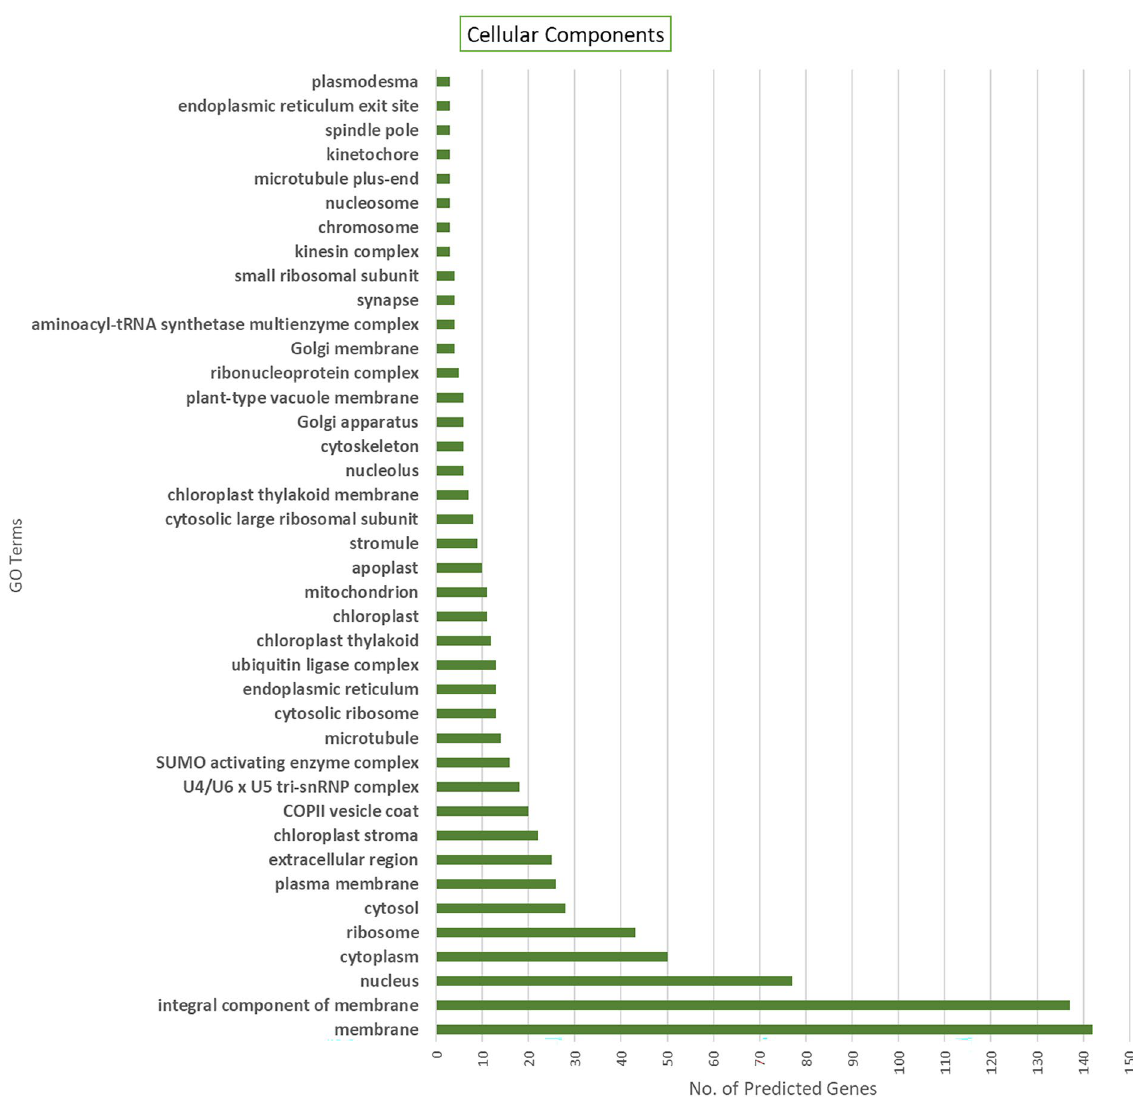
Figure 7. GO annotations distribution for the 128 SuperTranscripts assigned by Blast2GO 28 . This figure shows the associations of these sequences to the third domain of GO terms – Cellular Components. Majority of the SuperTranscripts seem to be associated with the terms – “integral component of membrane” and